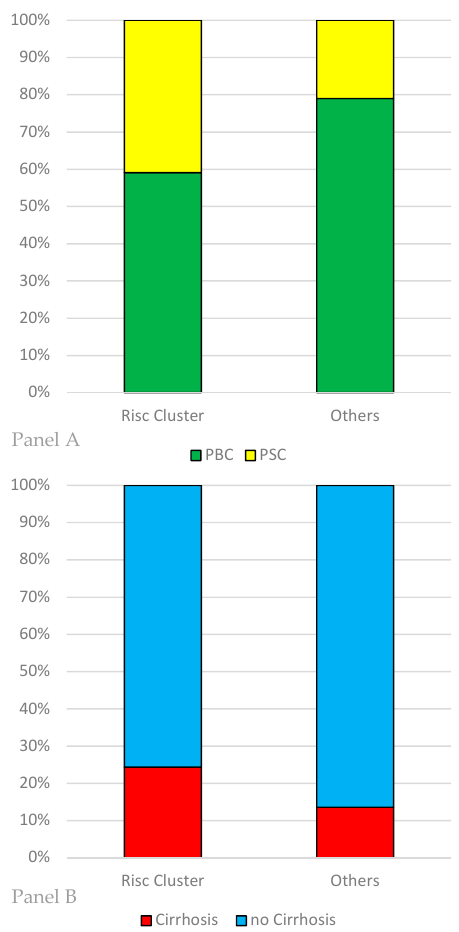
Figure 3. Characteristics of the subgroups formed by their allele variants in the two SNPs CTLA4 rs733618 and FOXP3 SNP rs2280883. If they were both homozygotic with the major variant (TT), defined as the predominant allele in the HapMap-population, they were included in the “risk cluster” ( n = 44). Afterwards, they were compared with the remaining patients with a di ff erent allele variant in the two SNPs ( n = 81). Panel A : Distribution of the disease entities in the risk cluster and the other patients. PSC appears more often in the “risk cluster” ( n = 18 / 44; 40% vs. n = 17 / 81, 21%, p = 0.03). Panel B : Patients in the “risk cluster” tend to present cirrhosis more often in our cohort ( n = 10 / 41, 24% vs. n = 11 / 81, 13%, p = 0.17).